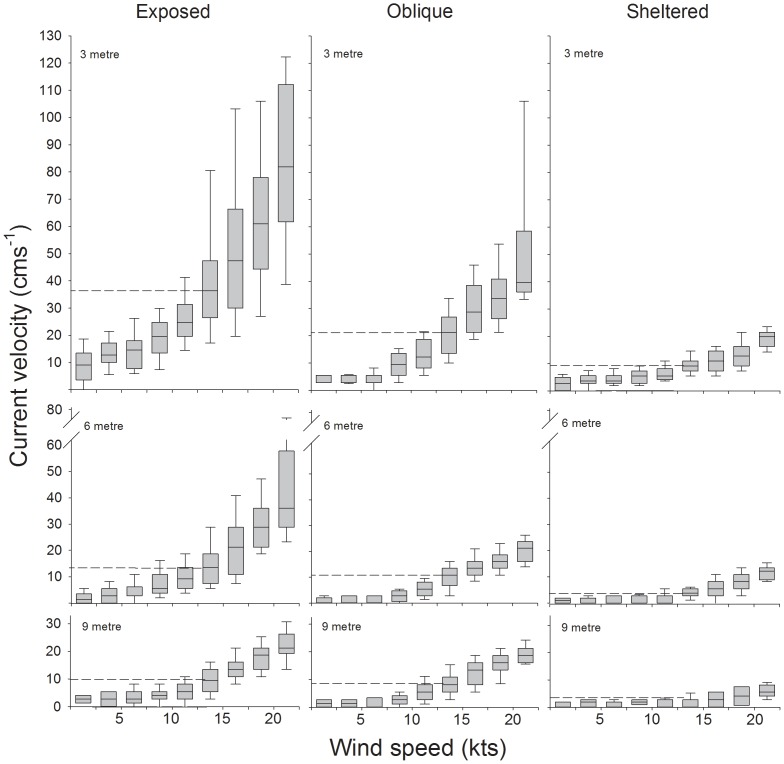
Current velocity profile of the coral reefs surrounding Lizard Island, Northern Great Barrier Reef, Australia.Maximum water velocities (cms−1) in exposed, oblique and sheltered habitats at 3, 6 and 9 m depth relative to a wind exposure of 0–22.5 knots hr−1 are shown. Boundary lines indicate the 25th and 75th percentiles, lines within the boxes represent median velocity values and the error bars indicate the 90th and 10th percentiles. Stippled lines indicate the most commonly encountered current velocity in each habitat relative to average daily wind velocities.